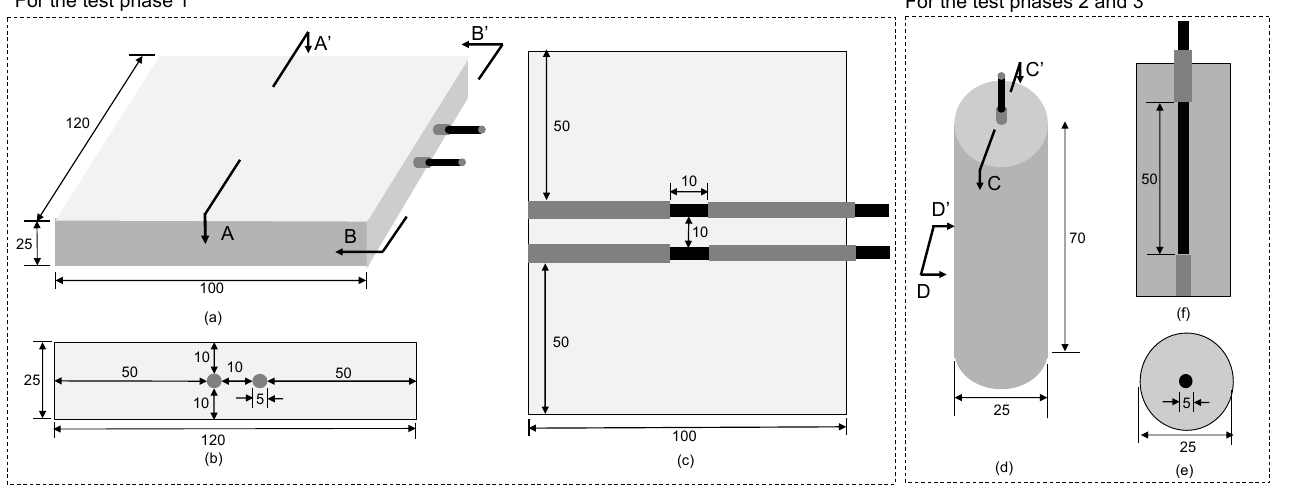
Figure 2. Configuration and dimensions of concrete samples used for the test phases 1, 2 and 3: ( a – c ) for isometric view, sectional view A-A’ and sectional view B-B’ for the concrete prism samples used in test phase 1, and ( d – f ) for isometric view, sectional view C-C’ and D-D’ for the concrete cylinder samples used in test phases 2 and 3.